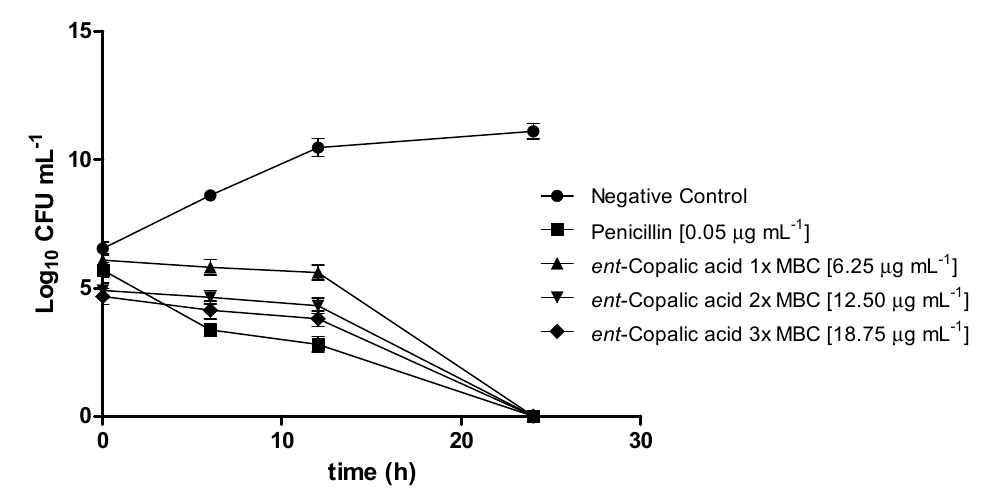
Figure 2. Time-kill curves for CA against S. aureus